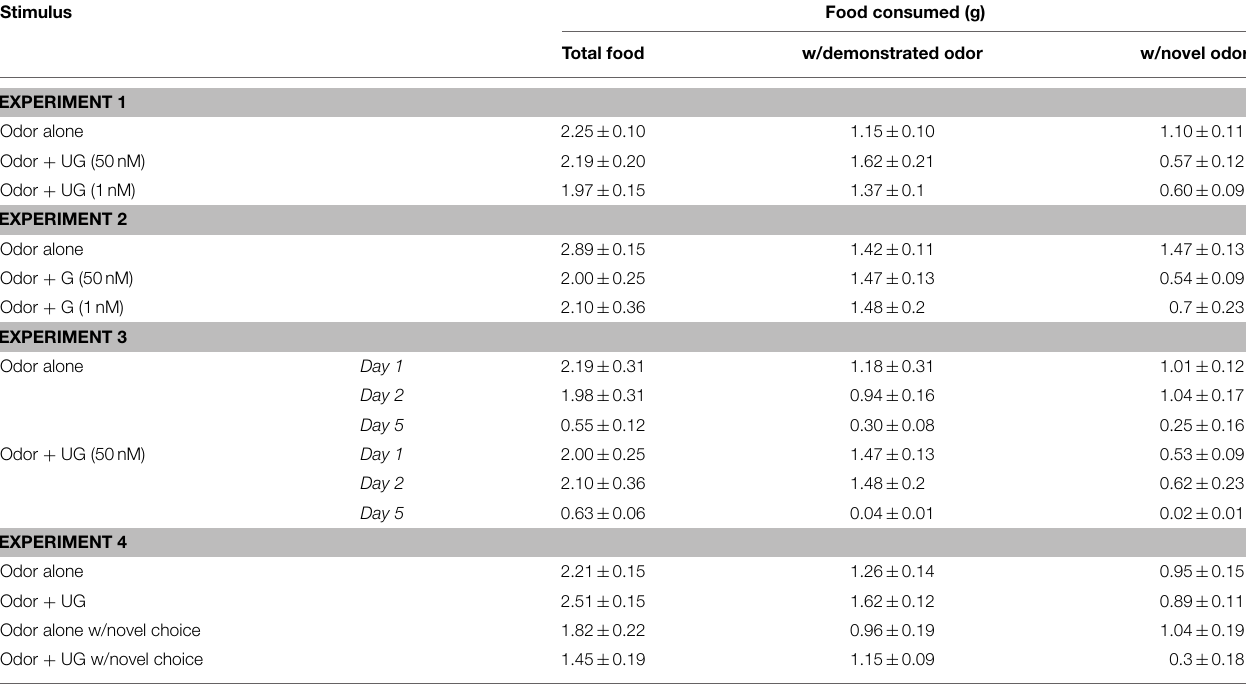
TABLE 1 | Food consumed by observer mice in food preference assays (mean ± s.e.m.). Stimulus Food consumed (g) Total food w/demonstrated odor w/novel